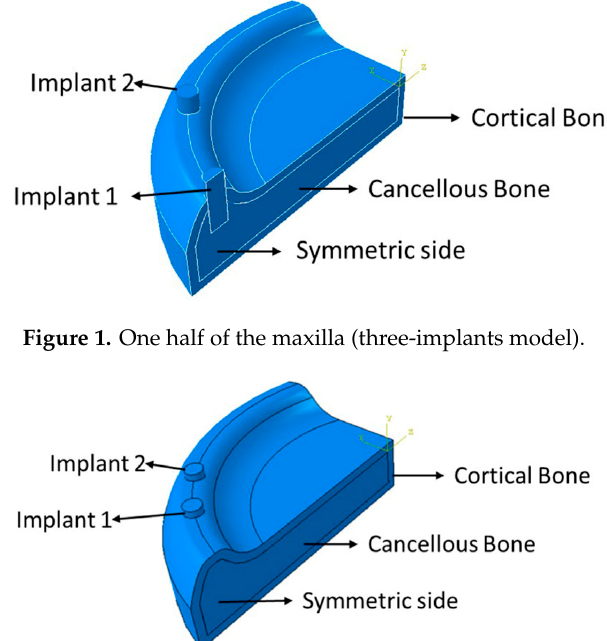
Figure 2. One half of the maxilla (four-implants model).